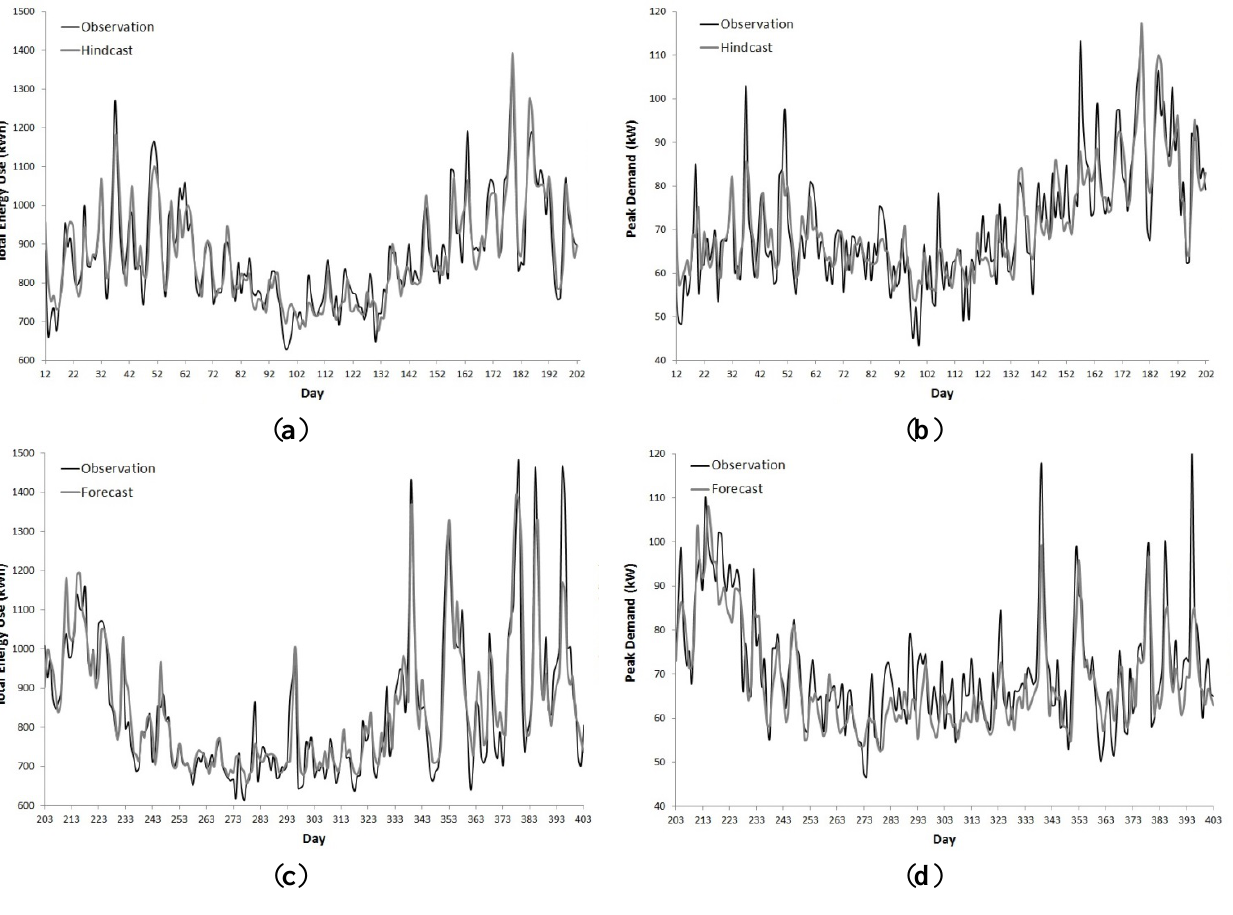
Figure 8. Phase 3’s Hybrid ARIMAX-NN models comparative assessment: ( a ) Hybrid NDTEU hindcast; ( b ) Hybrid NDPD hindcast; ( c ) Hybrid NDTEU forecast; and ( d ) Hybrid NDPD